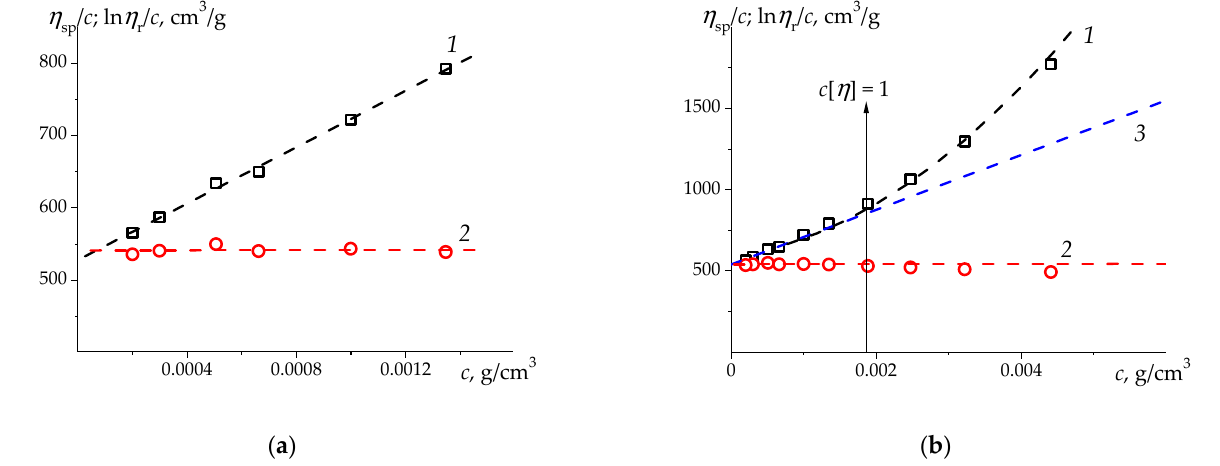
Figure 2. The Huggins (1) and Kraemer (2) plots for a sample of hydroxypropylmethylcellulose (HPMC) ( M sD = 207,000 g/mol) in H 2 O at 25 ◦ C [58]: ( a )—in the range of relative viscosities 1.11 < η r < 2.07, where extrapolation to c → 0 was carried out and the values of intrinsic viscosity and Huggins and Kraemer parameters were determined [ η ] H = ( 528 ± 4 ) cm 3 /g, k (cid:48) = 0.70 ± 0.03, r = 0.9984; [ η ] K = ( 541 ± 4 ) cm 3 /g, k (cid:48)(cid:48) = +( 0.002 ± 0.02 ) , r = 0.0637; 0.11 < c [ η ] < 0.73); ( b )—in the entire range of concentrations (Line 3 is drawn as a tangent to the 2-nd degree polynomial fit in the initial range of values η r < 1.4 which corresponds to following values: [ η ] H = 540 cm 3 /g, k (cid:48) = 0.35. Overall parabola (1) demonstrates the curvature of dependence of η sp / c in contrast with one of ln η r / c in the entire interval 1.11 < η r <